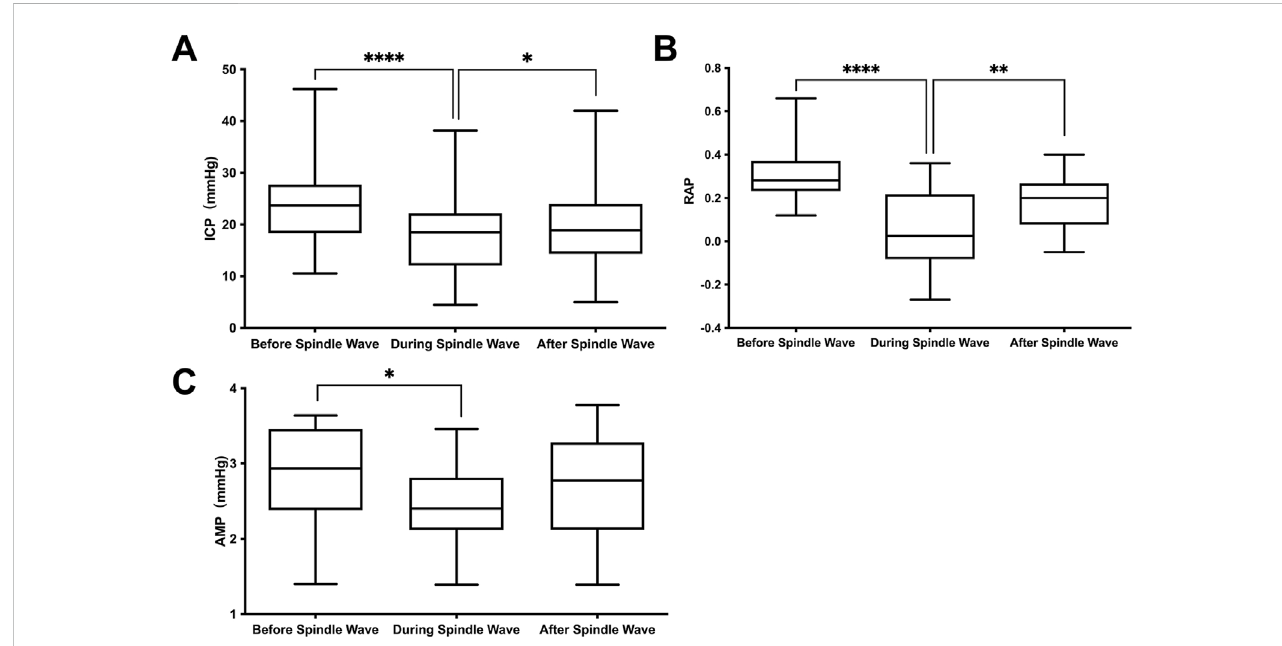
FIGURE 3 Relationship between the appearance of the spindle wave and ICP waveform parameters. (A) Intracranial pressure (ICP), (B) correlation coef fi cient between AMP and ICP (RAP) and (C) ICP pulse amplitude (AMP). *Difference with a con fi dence level of p < 0.025.